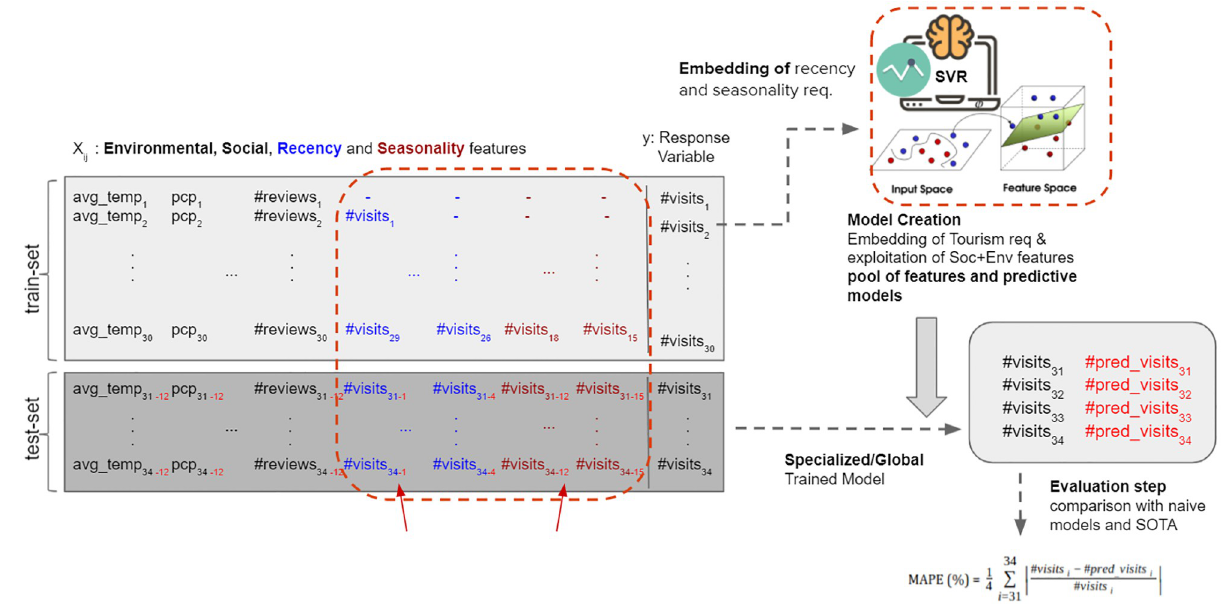
Fig 2. Tourism demand prediction methodology adopting social media, environmental, recency and seasonality features.